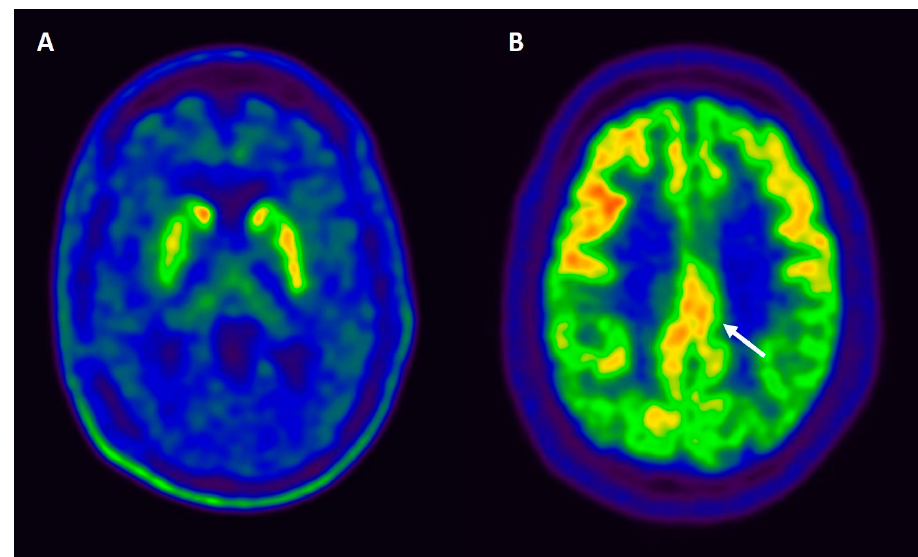
Figure 3. ( A ) Axial 18 F-Dopa PET image of a patient with dementia with Lewy bodies. The image shows a moderate decrease of bilateral striatal activity (dopaminergic denervation), more pronounced in the right putamen. ( B ) FDG-PET findings in a patient with dementia with Lewy bodies. Axial FDG-PET image demonstrates the cingulate island sign (indicated with an arrow), which reflects preservation of posterior cingulate metabolism relative to cuneus and precuneus.